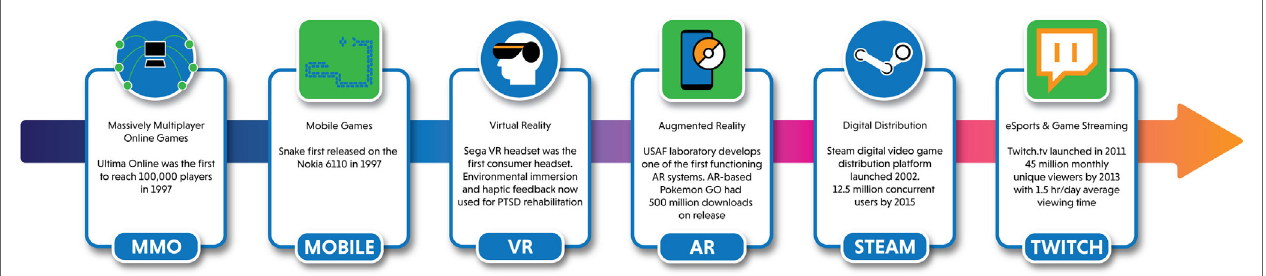
FiGURe 2 | Important milestones in the evolution of video games and gaming